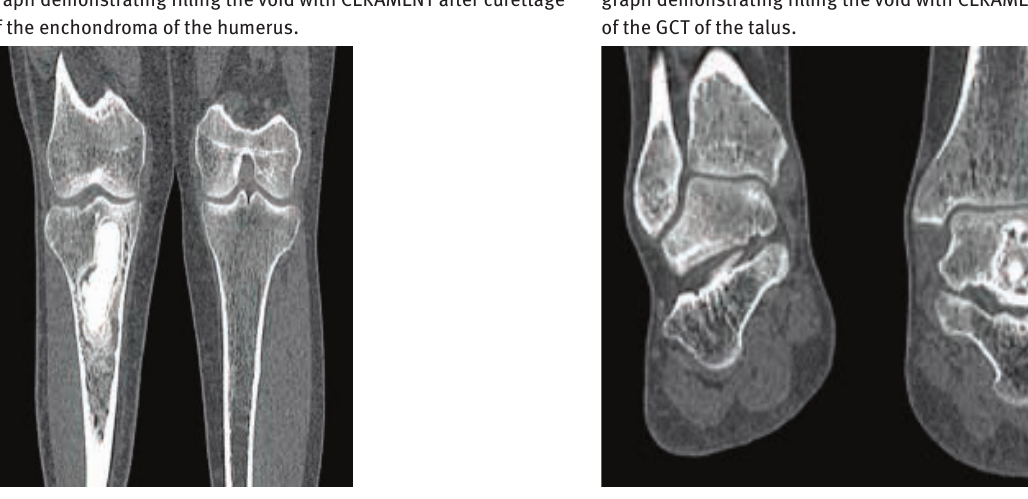
Figure 10: CT-scan of the talus at 5,5 months demonstrating further resorbtion of the CERAMENT and filling with new bone.